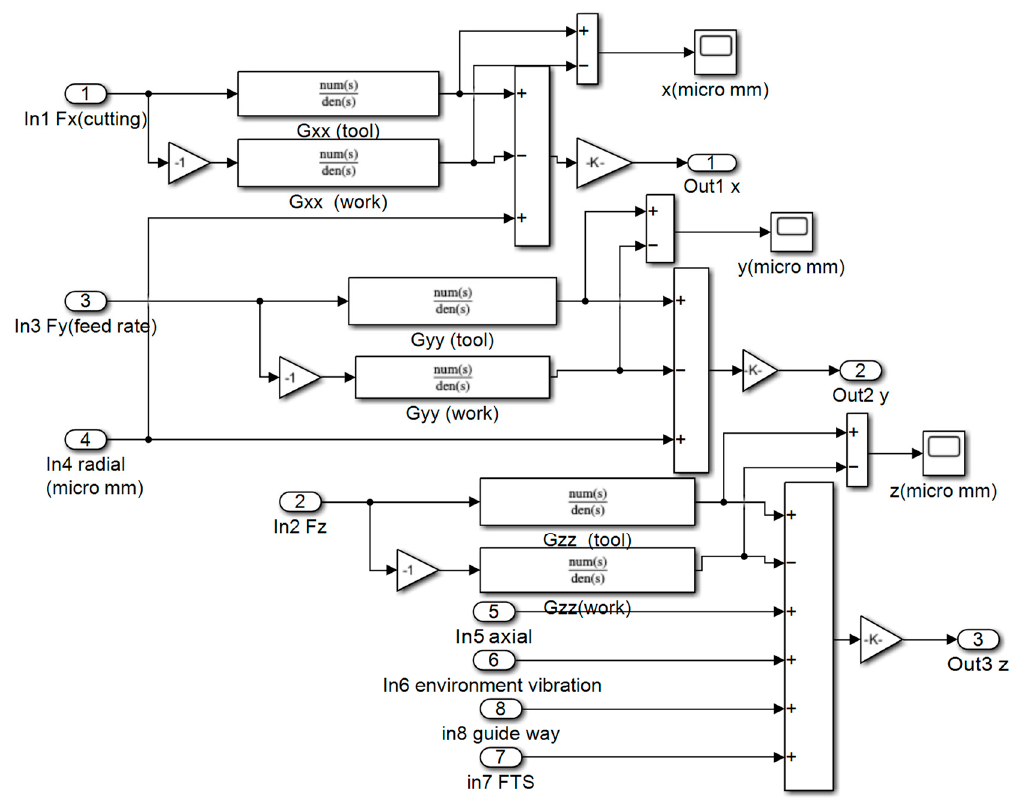
Figure 5. Simulink model of the dynamic displacements of the machined surface.